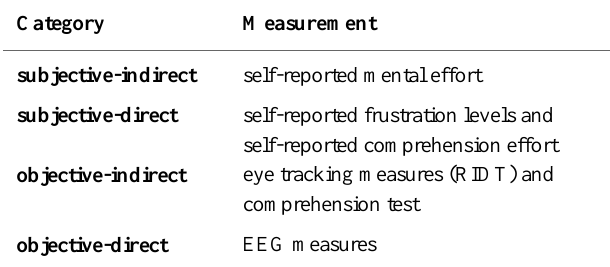
Table 1. Categorization of CL measurements used in the current